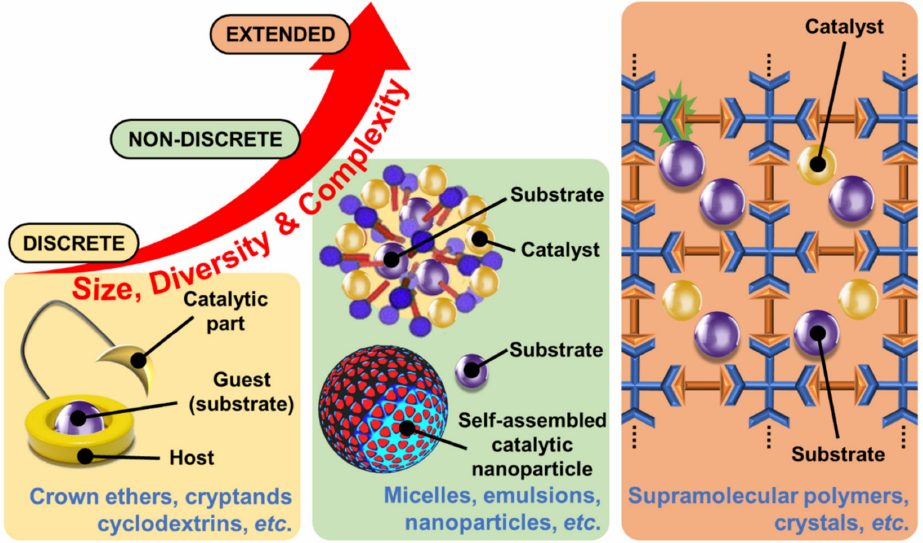
Figure 1. Some strategies for the engineering of catalytic systems from molecular building blocks by using supramolecular chemistry and